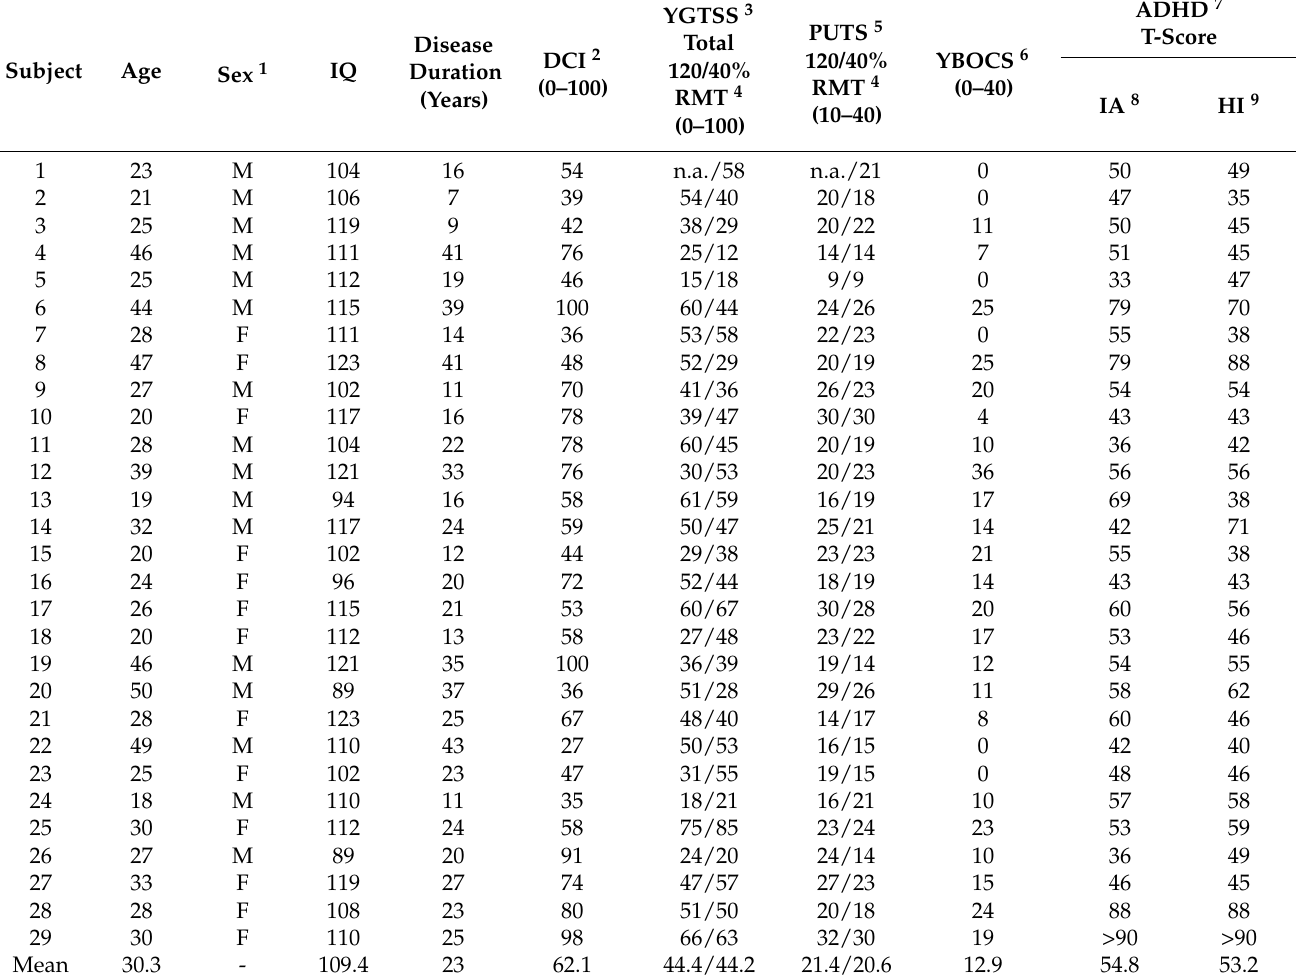
Table 1. Patient